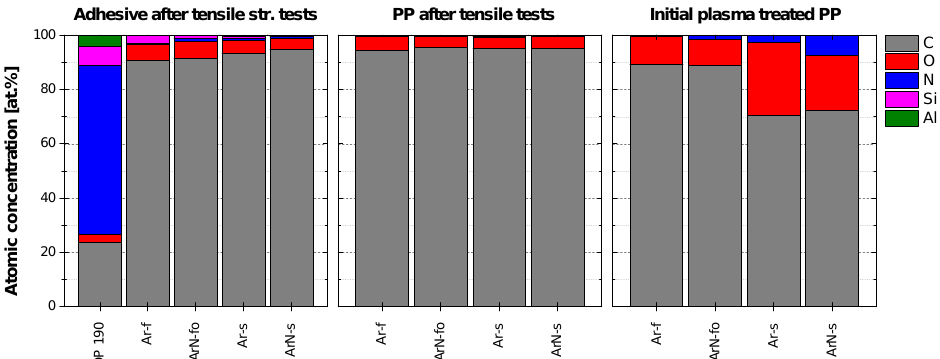
Figure 10. Elemental composition of the severed adhesive and PP surfaces measured after the tensile strength tests and of the initially unbounded plasma treated